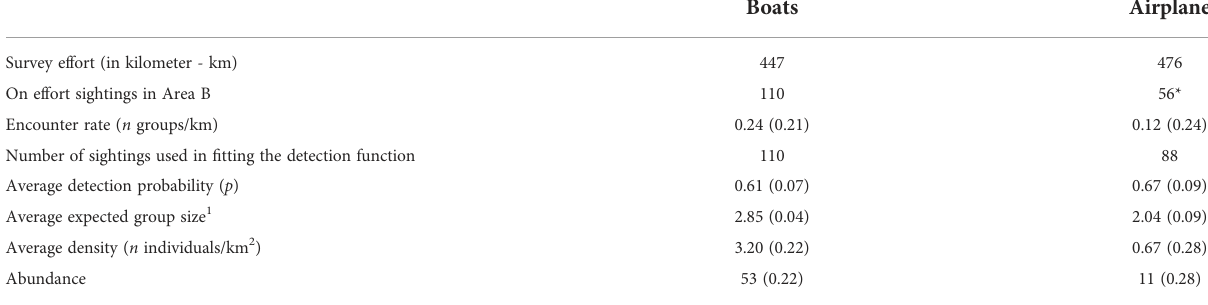
TABLE 6 Quantities used for estimation of density of franciscana dolphins in Babitonga Bay, southern Brazil, in February 2011.